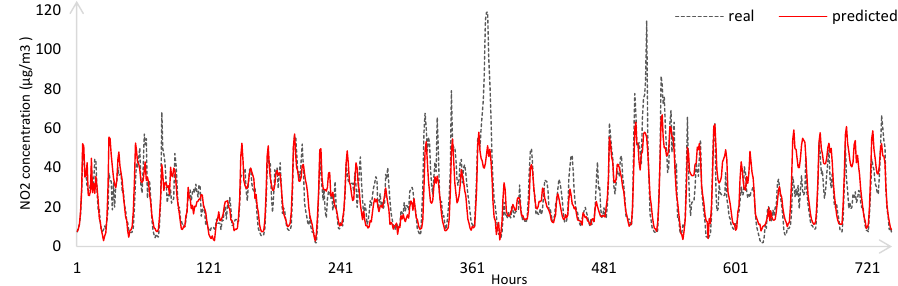
Figure 11. Real and predicted NO 2 , Sensor DETH081, September 2019, horizon: 120 h.